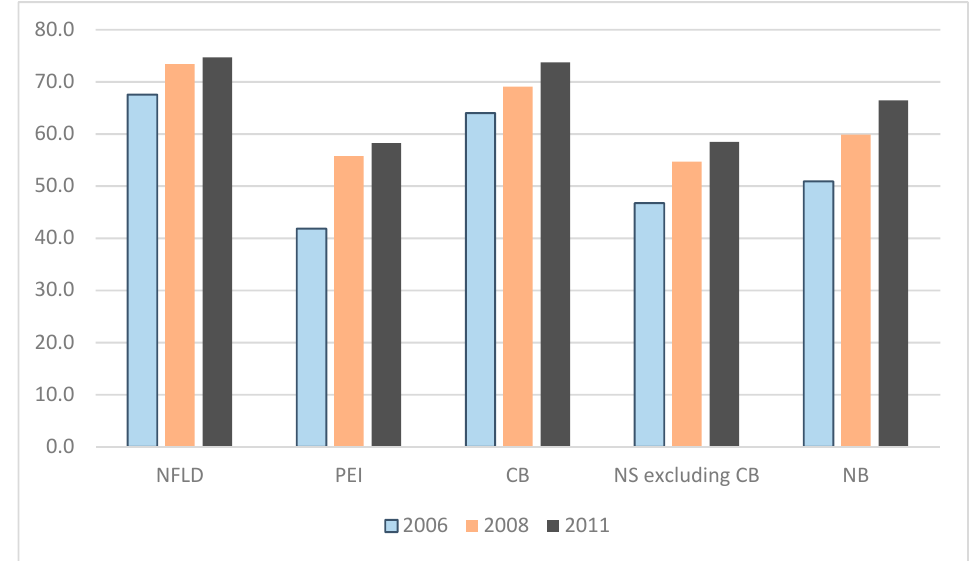
Figure 5. Percentage of Interprovincial employees earning 75% or more of their T4 earnings in